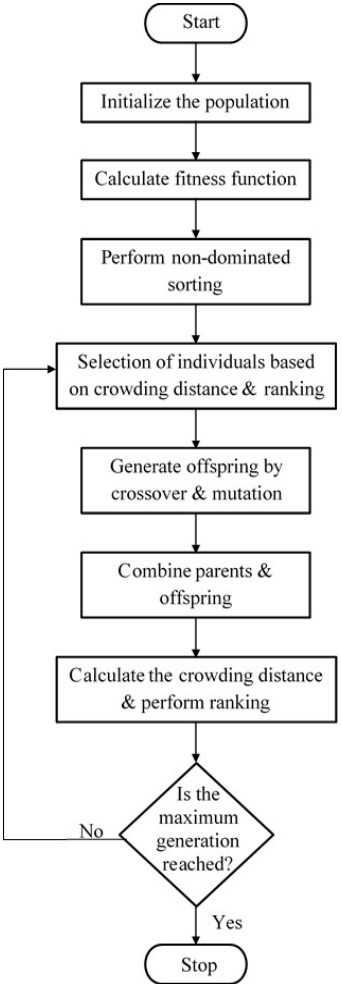
Figure 2. Flowchart for Non-dominated Sorting Genetic Algorithm-II (NSGA-II).